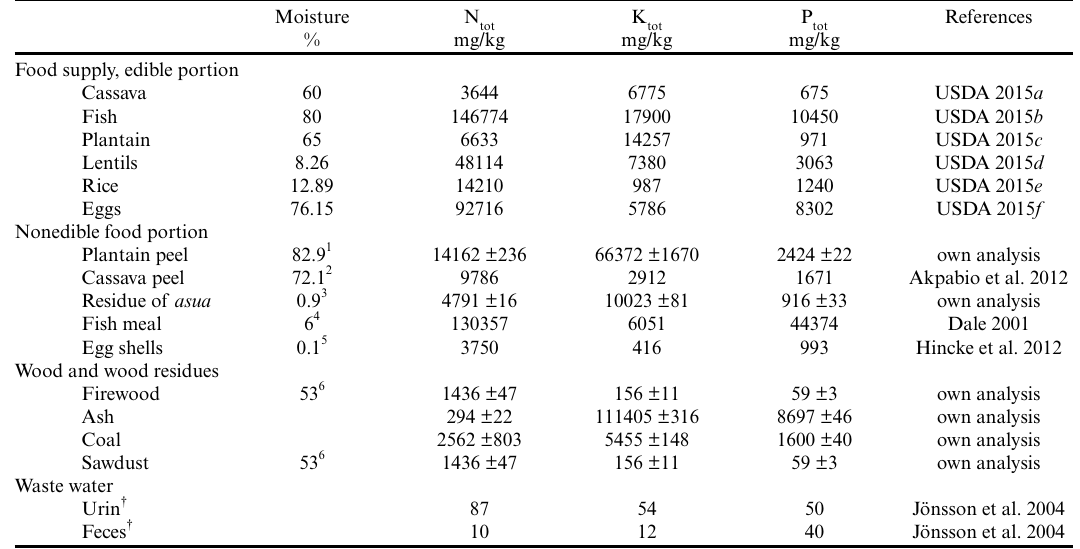
Table 1 . Total nutrient concentrations of substances used and produced in the household. Part of the values were derived by own analysis (n = 2), the other values were taken from literature. All moisture data was taken from literature, indicated by references and superscripts below.